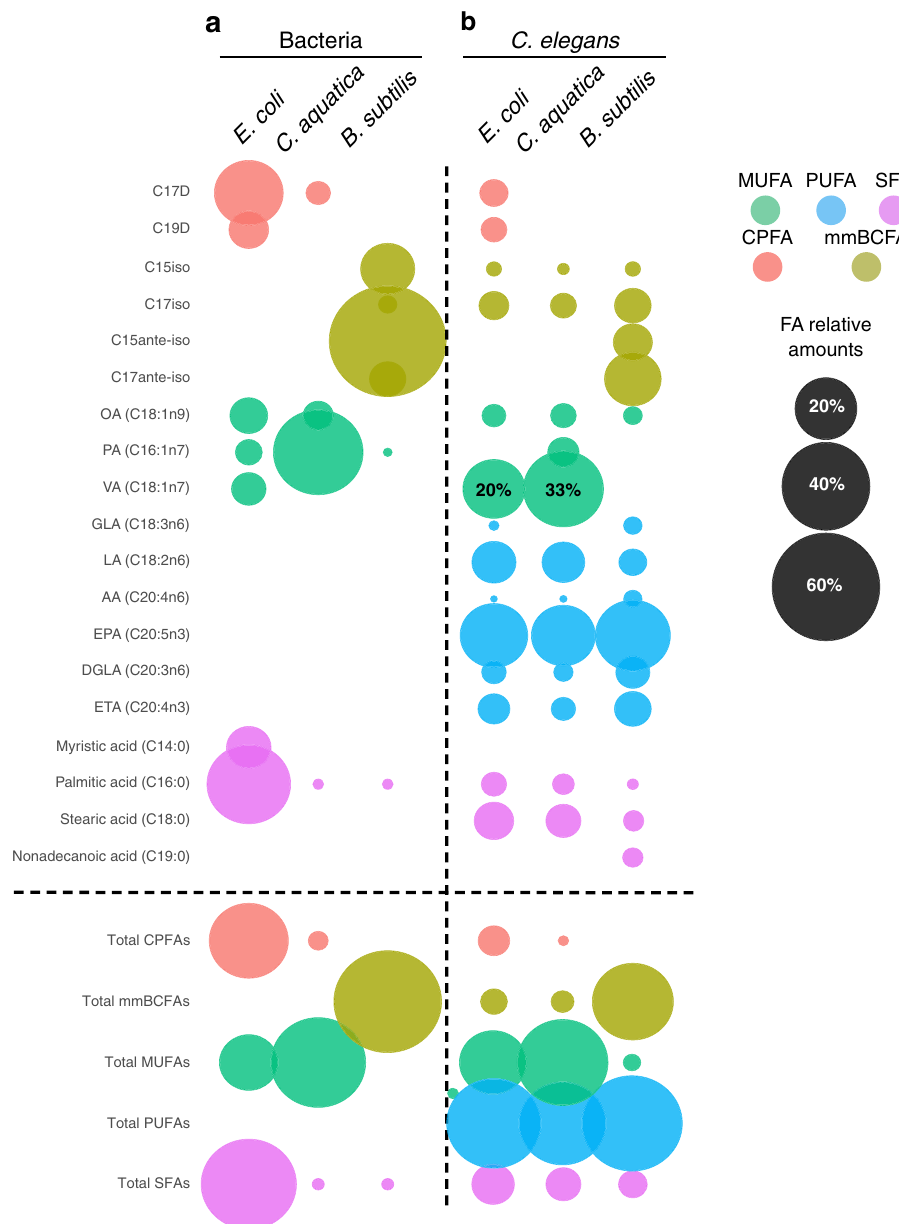
Fig. 4 | Long-chain fatty acid pro fi les of bacteria and C. elegans fed different bacteria.a , b Bubbleplotsshowinglong-chainfattyacidproportionsmeasuredby GC-MS in the indicated bacteria ( a ) and animals fed the indicated bacteria ( b ). Bubble sizes are indicative of FA ratios within the sample of interest and are not